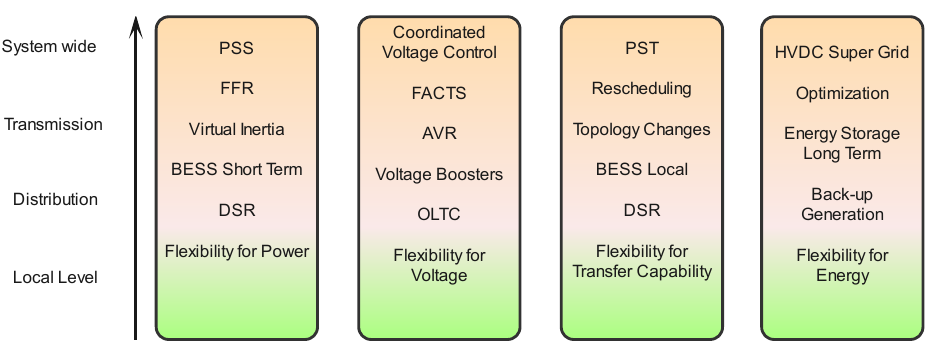
Figure 9. Flexibility provisions.